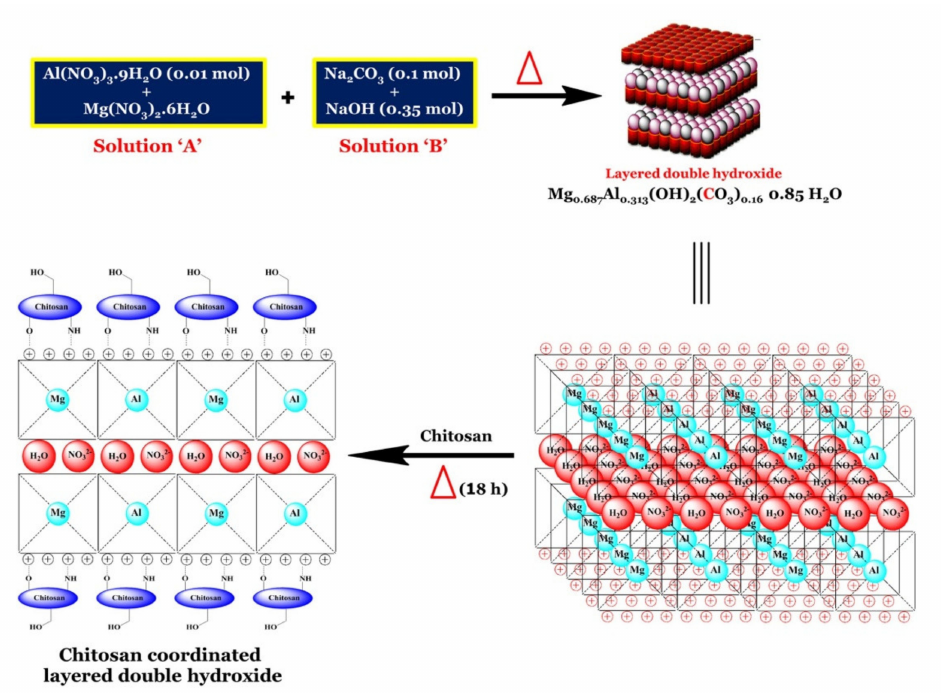
Figure 25. Preparation of CS/Mg-Al layered double hydroxide composite [149]. Reproduced with permission from Elsevier